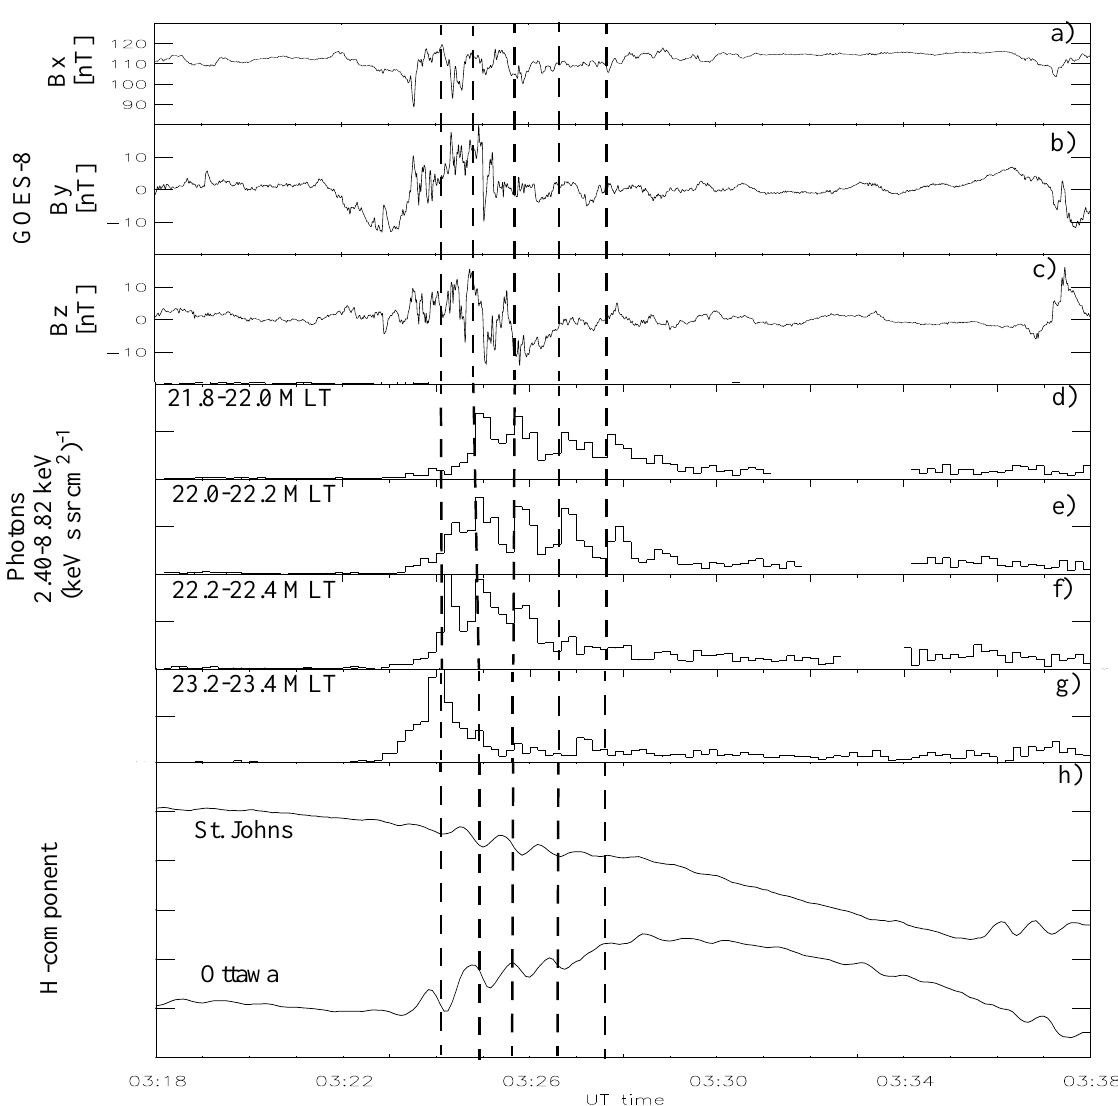
Fig. 7. A composite plot. Panels ( a ) to ( c ) show the magnetic field measured by GOES-8 in geosynchronous orbit converted into field- aligned coordinates. The field-aligned direction, B x , is based on a 5min average field direction. B y is in the direction perpendicular to B x and the spin aligned component B p which is northward. Panels ( d ) , ( e ) and ( f ) are selected MLT sectors from Fig. 5. Panel ( g ) shows the H component of the two Northern Hemisphere stations Ottawa and St.